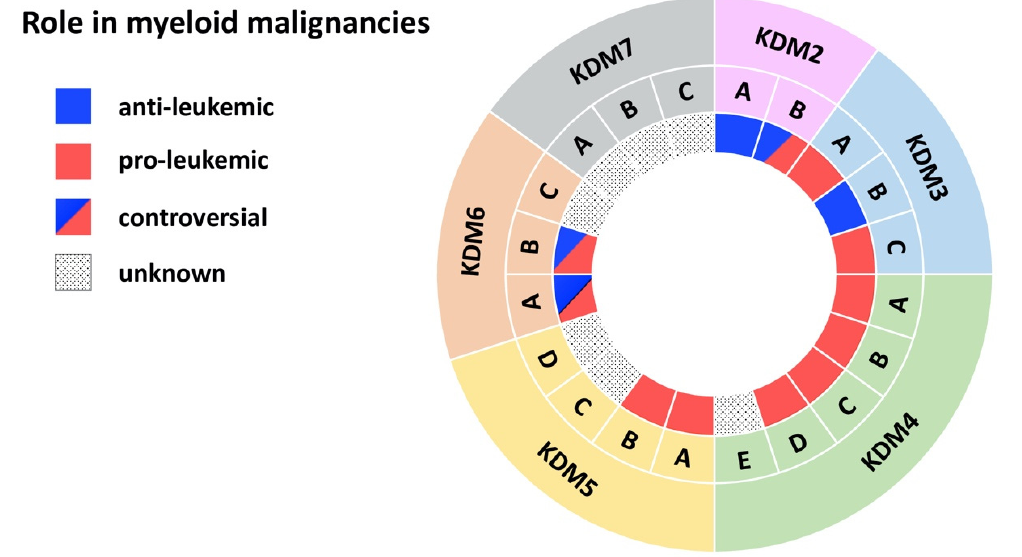
Figure 2. JmjC domain-containing histone demethylases in myeloid malignancies. The outer ring names the KDM subfamily, while the middle ring specifies members of each subfamily. The inner ring indicates the role in myeloid malignancies: blue (anti-leukemic), red (pro-leukemic), blue and red (controversial role), black dots (unknown role). Table 1. Involvement of JmjC domain-containing histone demethylases in myeloid malignancies. Demethylase Disease